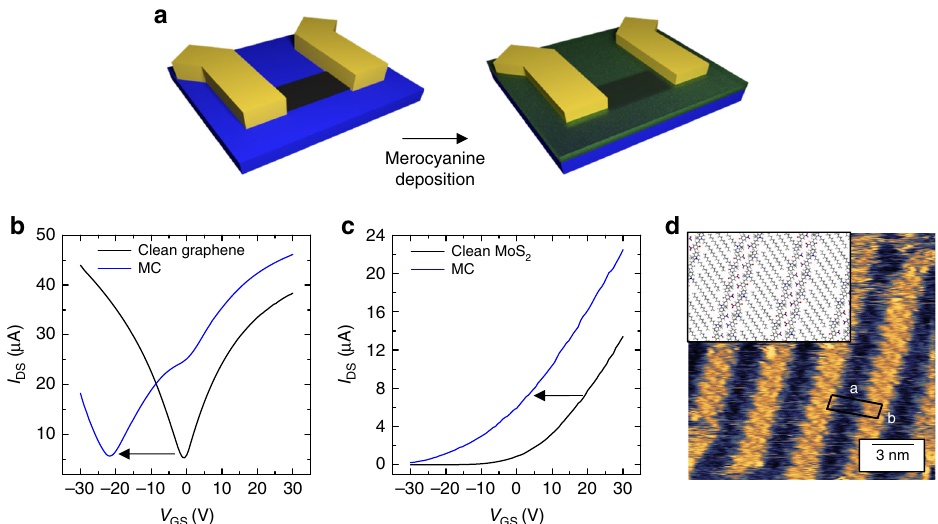
Fig. 4 Effect of the direct deposition of the merocyanine isomer. a Schematics of the experiment. Transfer characteristics ( I DS – V GS ) are measured for clean graphene and MoS 2 devices before and after the deposition of a merocyanine fi lm. b I DS – V GS of a clean graphene device (in black) and of the same device covered by a directly deposited merocyanine (MC) assembly (in blue). c I DS – V GS of a clean MoS 2 device (in black) and of the same device covered by a directly deposited MC assembly (in blue). The directly deposited MC layer introduced signi fi cant n -type doping in both graphene and MoS 2 , qualitatively and quantitatively similar to that observed upon irradiation of the spiropyran assembly on the devices. The transfer curves were measured applying a drain source voltage V DS = 10 mV for graphene and V DS = 1 V for MoS 2 . Channel length L = 4.6 µ m and width W = 10.6 µ m (graphene); L = 1.4 µ m, W = 1.0 µ m (MoS 2 ). d Scanning tunneling microscope height image of the assembly of a directly deposited MC fi lm on highly oriented pyrolytic graphite. Measured unit cell parameters: a = 3.9 ± 0.2 nm, b = 1.1 ± 0.1 nm, and α = 90 ± 2°, therefore leading to an area A = 4.2 ± 0.2 nm 2 . Inset: Calculated MC assembly on the basis of molecular dynamics simulations. Tunneling parameters: average tunneling current I t = 20 pA, tip bias voltage V t = 600 mV. In the three cases, the SP → MC isomerization was obtained through irradiation of an SP solution with UV light immediately before spin